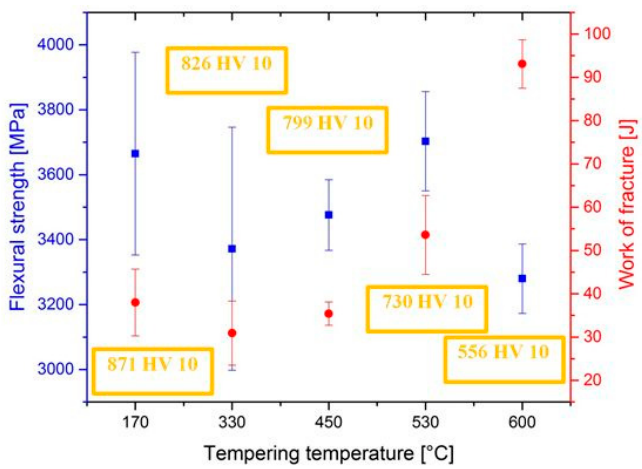
Figure 6. Flexural strength and work of fracture obtained by flexural three-point bend test for steel with application of SZT at − 75 °C for 17 h, and subsequent tempering.